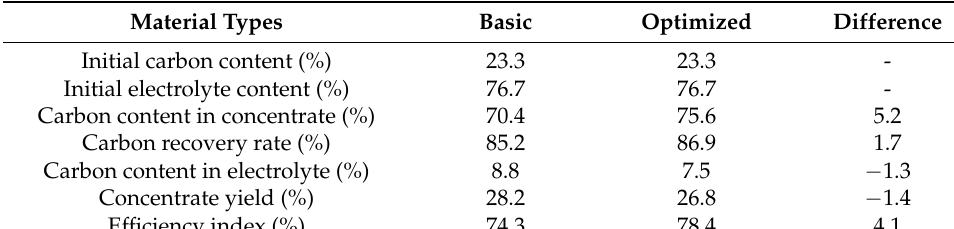
Table 6. Comparison of basic and optimized industrial process experiments.